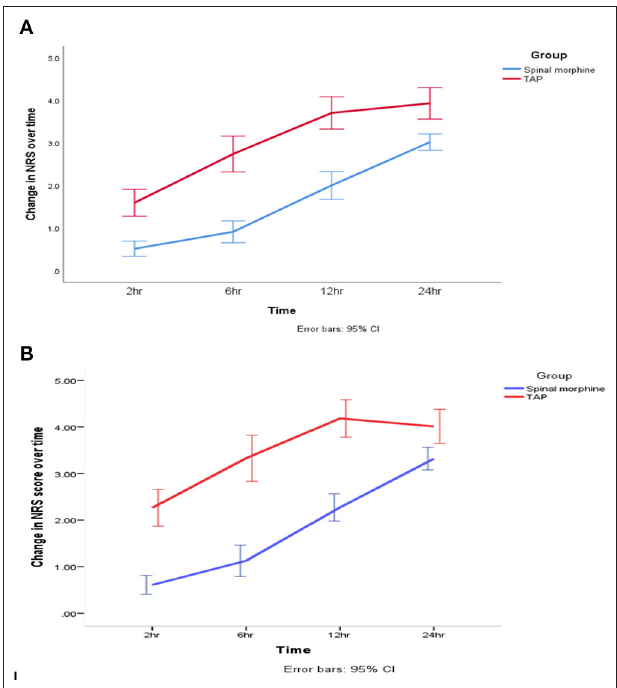
FIGURE 4 | Change in postoperative pain score. (A) At rest. (B) On movement during the 24-h postoperative period. SM, spinal morphine; TAP block, transversus abdominis plane block; NRS, numerical rating score. The line indicates mean, and hinges indicate 95% CI.